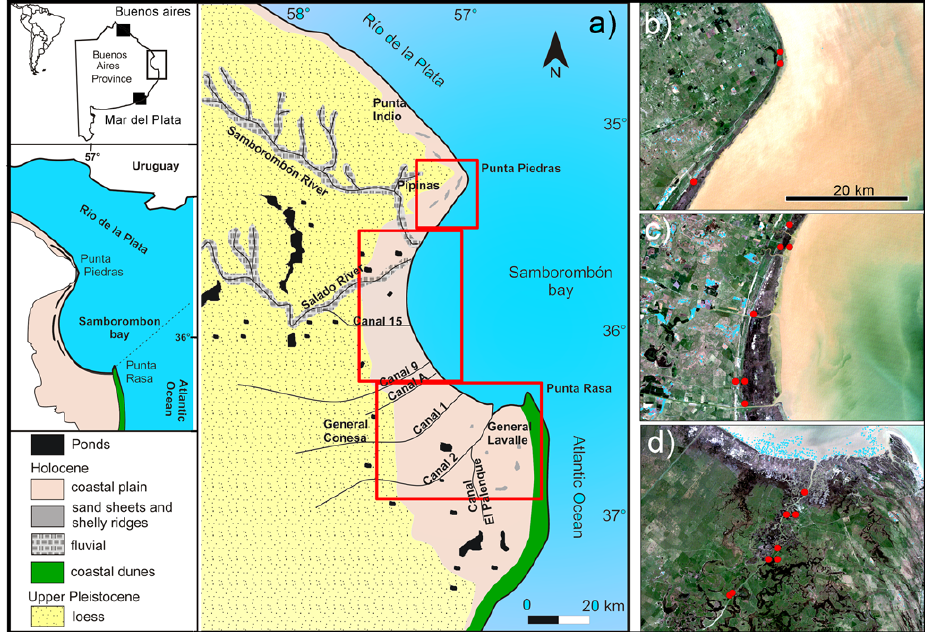
Fig. 1. (a) Simplified geological-geomorphological map of the Samboromb´on coastland. Landsat images of the (b) northern, (c) central, and (d) southern sectors of the study area. The location of the groundwater and surficial-water monitoring stations are represented by red dots.